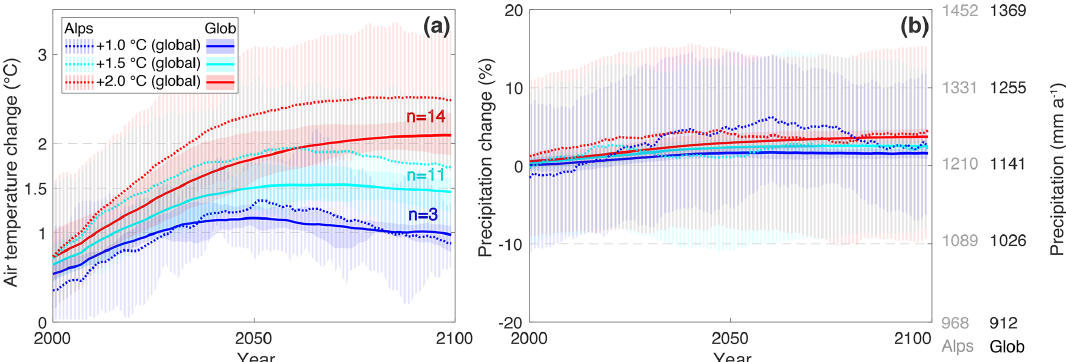
Figure 1. Evolution of annual global and Alpine (a) average air temperature and (b) precipitation total compared to the preindustrial (1850– 1900) baseline. Series are smoothed with a 30-year running mean. The coloured bands show the standard deviation of the projection given by individual GCM members. n is the considered number of GCM members.